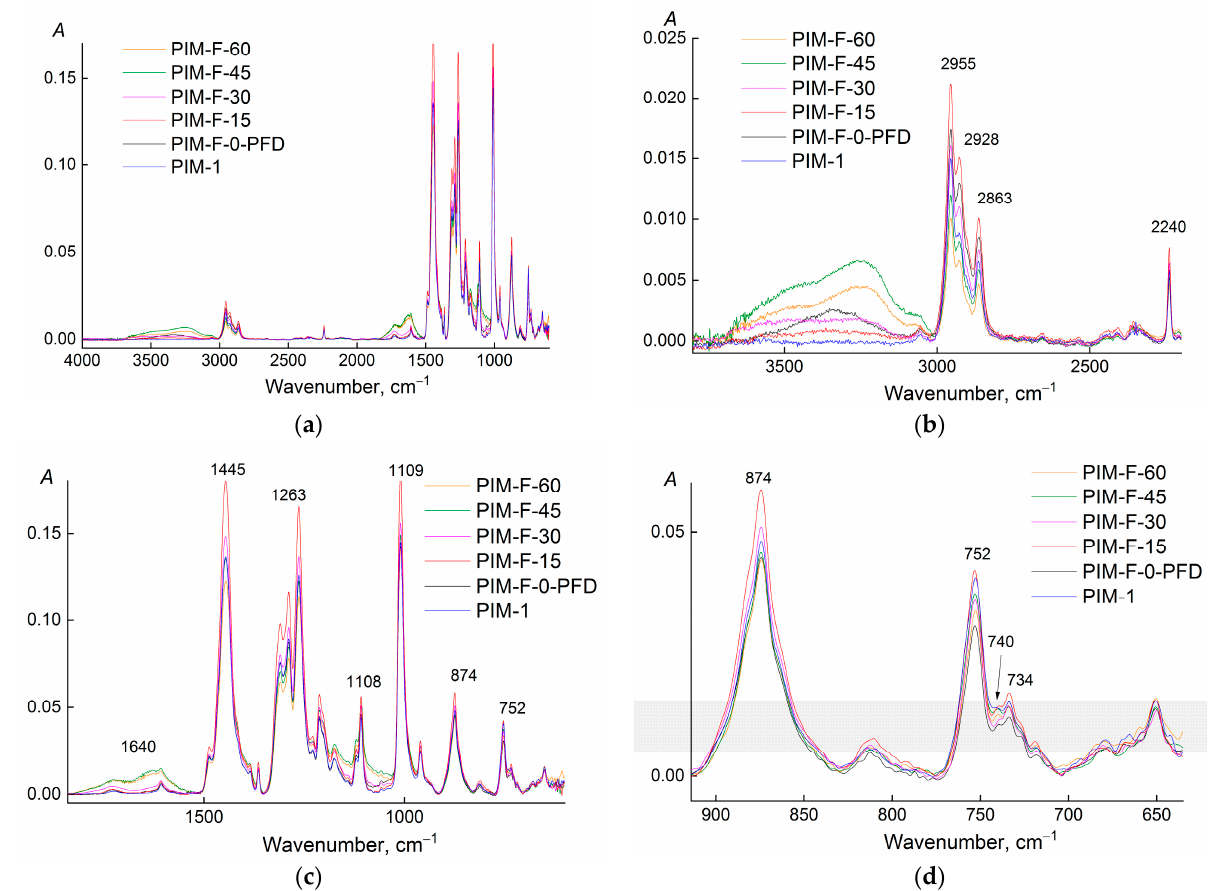
Figure 3. ATR-IR spectra (ZnSe crystal) of virgin PIM-1 film, PIM-1 film soaked in PFD (PIM-F-0-PFD), and PIM-1 films treated by fluorination mixture [F 2 (10 vol.%) + N 2 ] in perfluorodecalin for 15 (PIM-F-15), 30 (PIM-F-30), 45 (PIM-F-45) and 60 min (PIM-F-60) at (22 ± 2) °C for different ranges of wavenumbers. ( a ): full-scale spectra; ( b ): zoomed in 2000-4000 cm − 1 region of the spectra; ( c ): zoomed in 500-2000 cm − 1 region of the spectra; ( d ): zoomed in 650-900 cm − 1 region of the spectra.